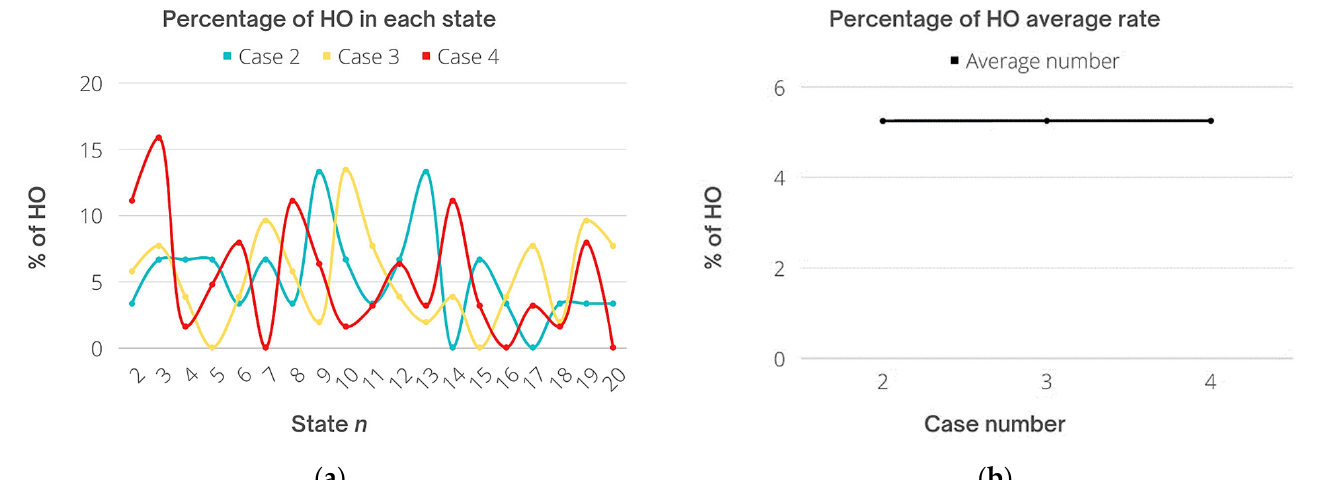
Figure 14. Percentage of HO rates. ( a ) Throughout each state, and ( b ) Total and the average number of each case.